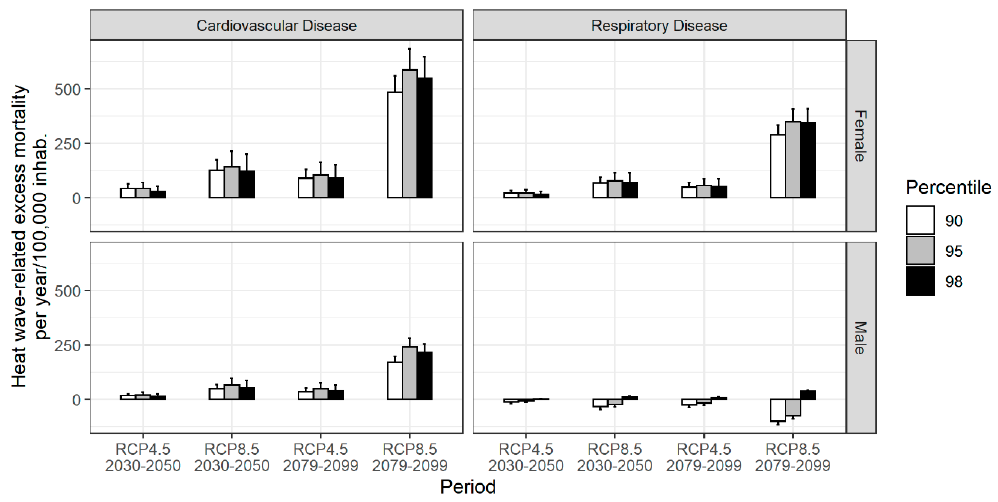
Figure 4. Heat wave-related excess mortality of elderly people per year in each 100,000 inhabitants from cardiovascular and respiratory diseases for female and male genders. Projections for near future (2030–2050) and distant future (2079–2099) under RCP4.5 and RCP8.5 climate change scenarios considering the non-adaptation assumption. The colors are percentiles of maximum temperature (90th, 95th and 98th).